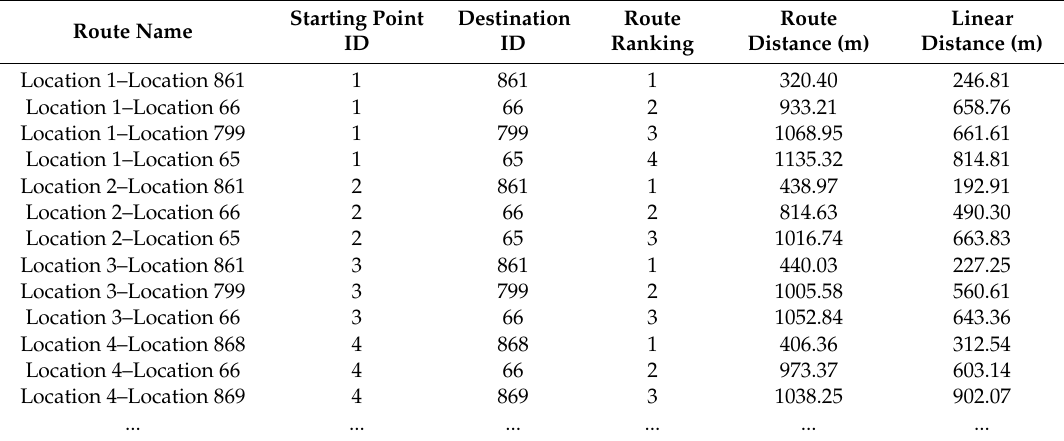
Table 4. Information of evacuation routes calculated by OD cost matrix.